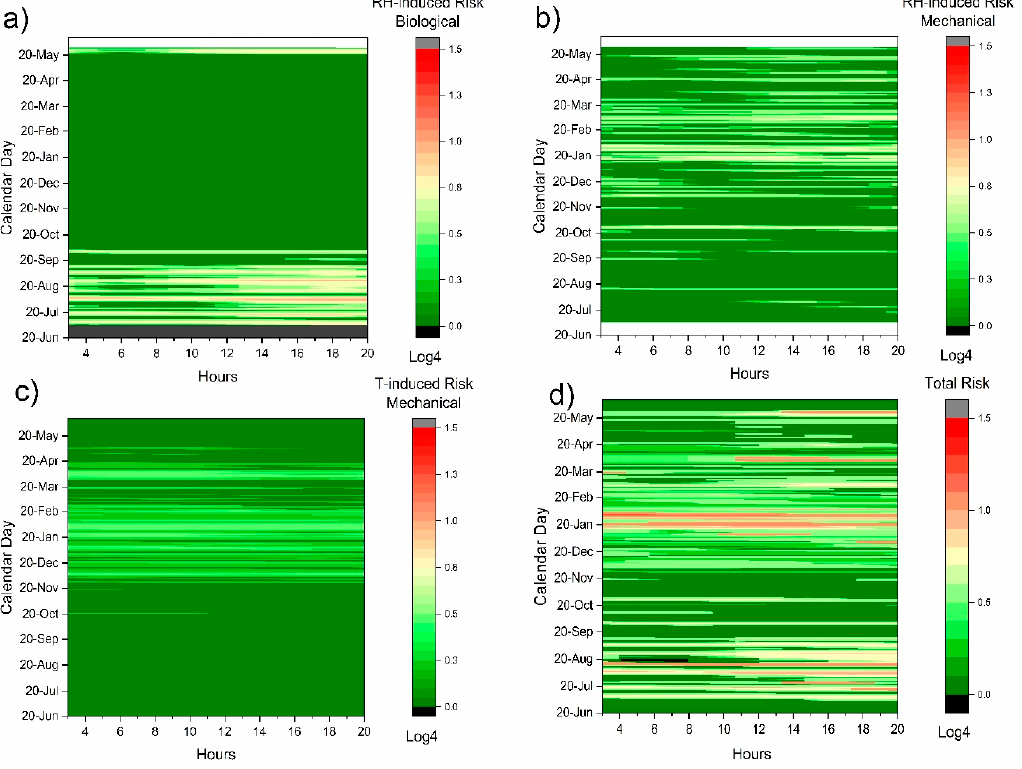
Figure 10. ( a ) RH-induced risk of biological decay on wood (i.e., woodworm and fungi infestation). ( b ) RH-induced risk of mechanical decay caused by wider RH fluctuation than the historic climate as stated in the EN15757:2010 standard; ( c ) T-induced risk of mechanical decay on wood (i.e., freezing–thawing cycles; ( d ) total risk (i.e., sum of the previous three types of calculated risk to show the synergetic effect. Colors associated to the maps are related to the index value reported on the scale: green from 0 to 0.5 indicates low risk conditions; yellow to orange, from 0.5 to 0.75 indicates moderate risk; red, approaching 1.5 indicates high risk.